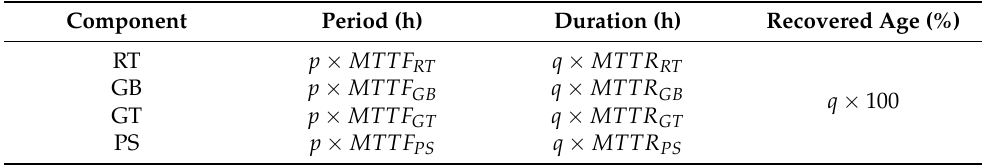
Table 7. Preventive maintenance models of individual component.